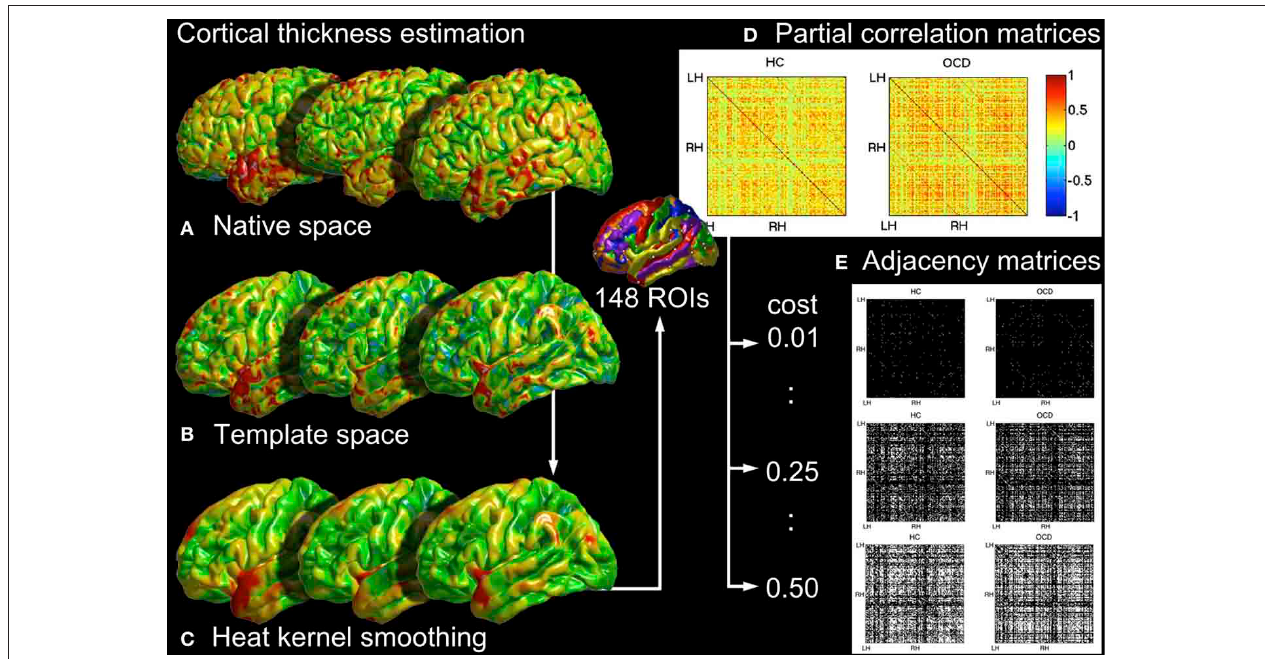
FIGURE 1 | The illustration of analysis steps to construct networks from MRI. The cortical thicknesses are estimated in native spaces ( A , section 2.2.1), normalized into the template space ( B , section 2.2.2), and smoothed by a heat